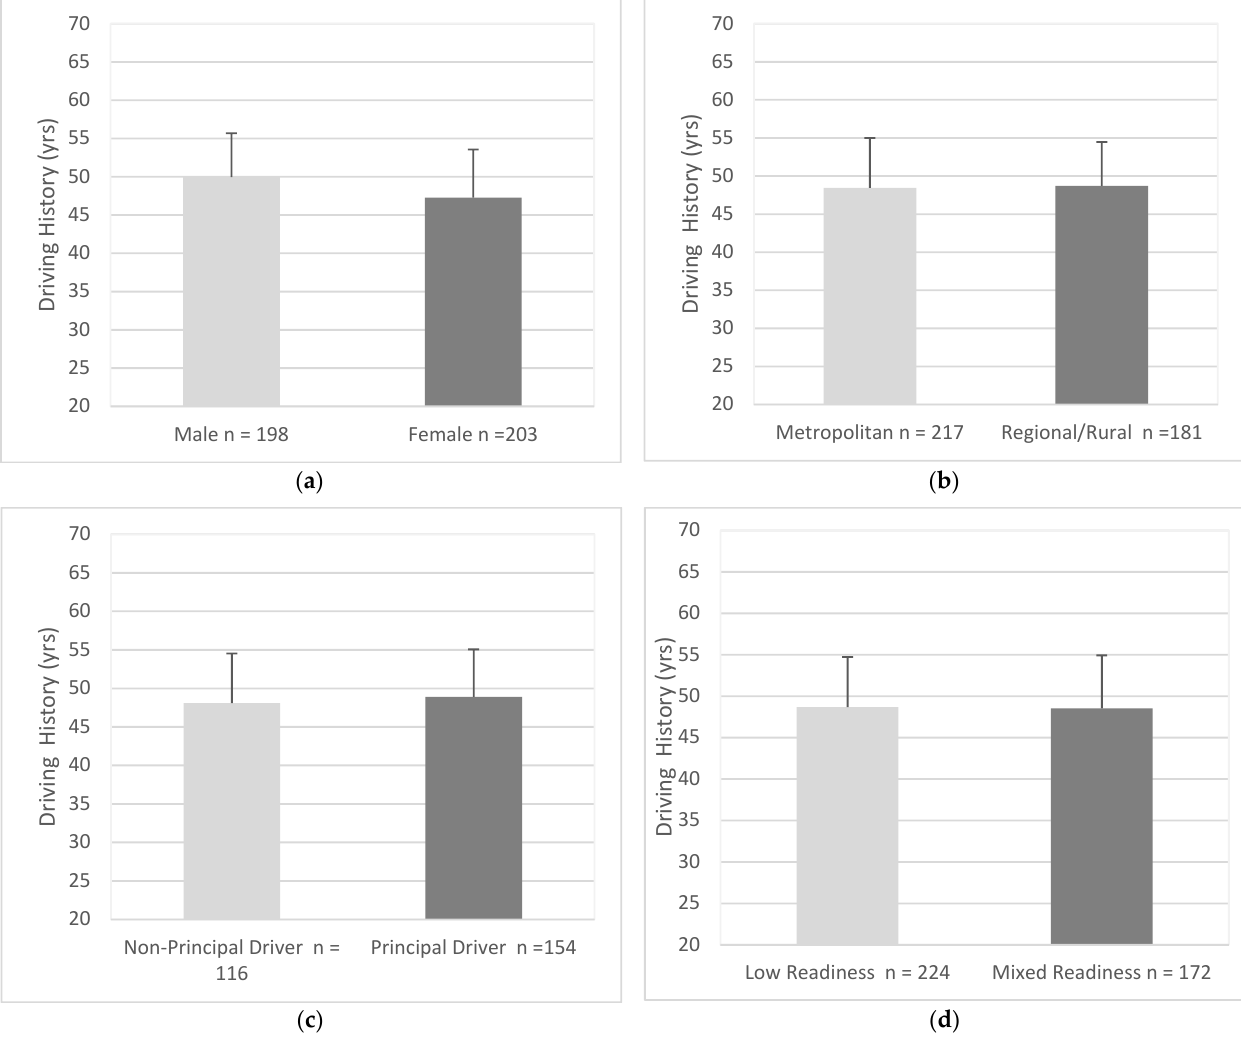
Figure 1. Differences in driving history between groups; ( a ) Gender, ( b ) Residential Area, ( c ) Driving Roles, ( d ) Readiness. Error bars represent standard deviation.